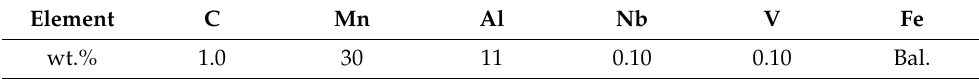
Table 1. Chemical composition of Fe-30Mn-11Al-1C-0.1Nb-0.1V steel (wt.%).